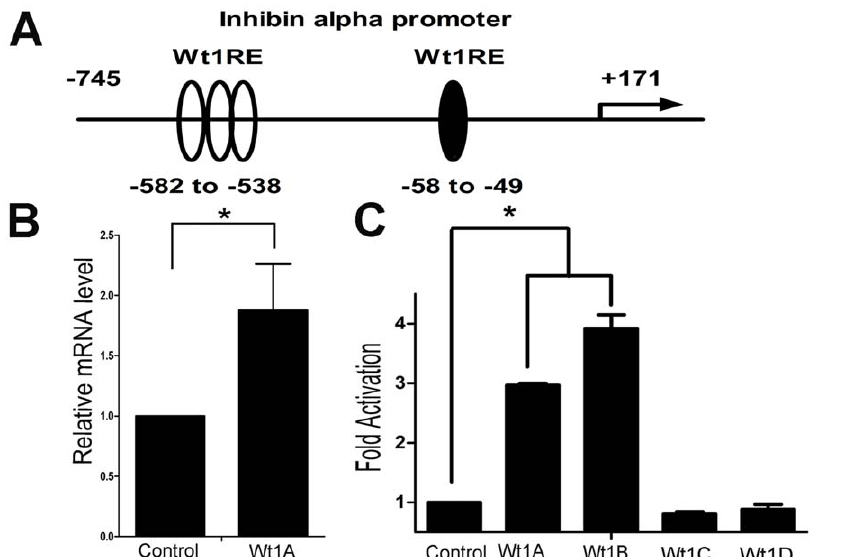
Figure 2. The inhibin alpha promoter is transactivated by the Wt1 A and B isoforms ( 2 KTS), but not the C and D isoforms ( + KTS). A, Schematic drawing of inhibin- a promoter. The open and filled ovals indicate the putative Wt1 binding sites. B, Real-time PCR results showed the elevated endogenous inhibin- a expression in primary Sertoli cells after transfection with Wt1A. C, The inhibin- a promoter was transactivated by the Wt1 A and B isoforms ( 2 KTS), but not the C and D isoforms ( + KTS). TM4 cells were transiently transfected with a luciferase reporter plasmid termed pGL3-Inhibin alpha ( 2 745) and a Renilla luciferase reporter plasmid along with Wt1-expressing vectors. Luciferase activity was examined 36 h later. Compared to control cells, the luciferase activity was significantly increased in Wt1 A and B transfected TM4 cell, not in C and D isoforms transfected cells. (* p , 0.05, Wt1A: 2 Exon5, 2 KTS; Wt1B: + Exon5, 2 KTS; Wt1C: 2 Exon5, + KTS; Wt1D: + Exon5, + KTS).